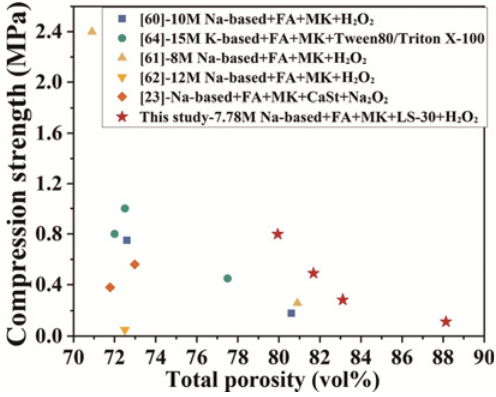
Fig. 5 Comparison of porosity and compressive strength for the samples produced in this work with those for porous geopolymers manufactured using FA and MK as the main raw materials, reported in Refs.